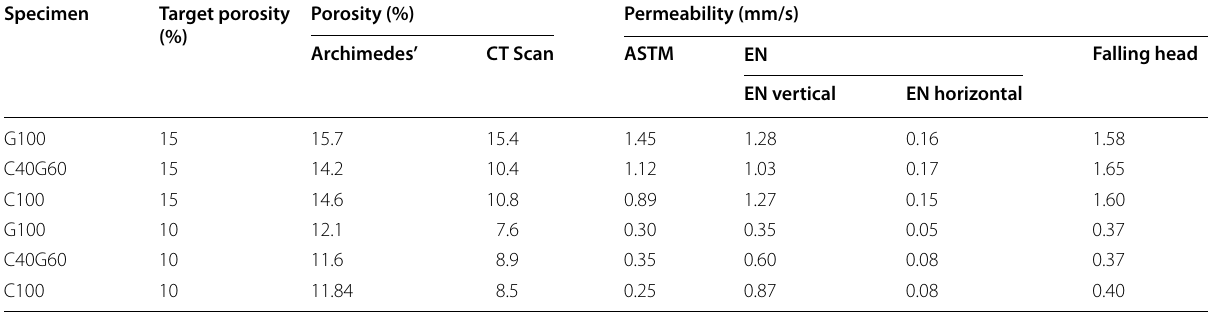
Table 4 Porosity results measured with the water absorption (Archimedes’) method and CT scan and water permeability results.